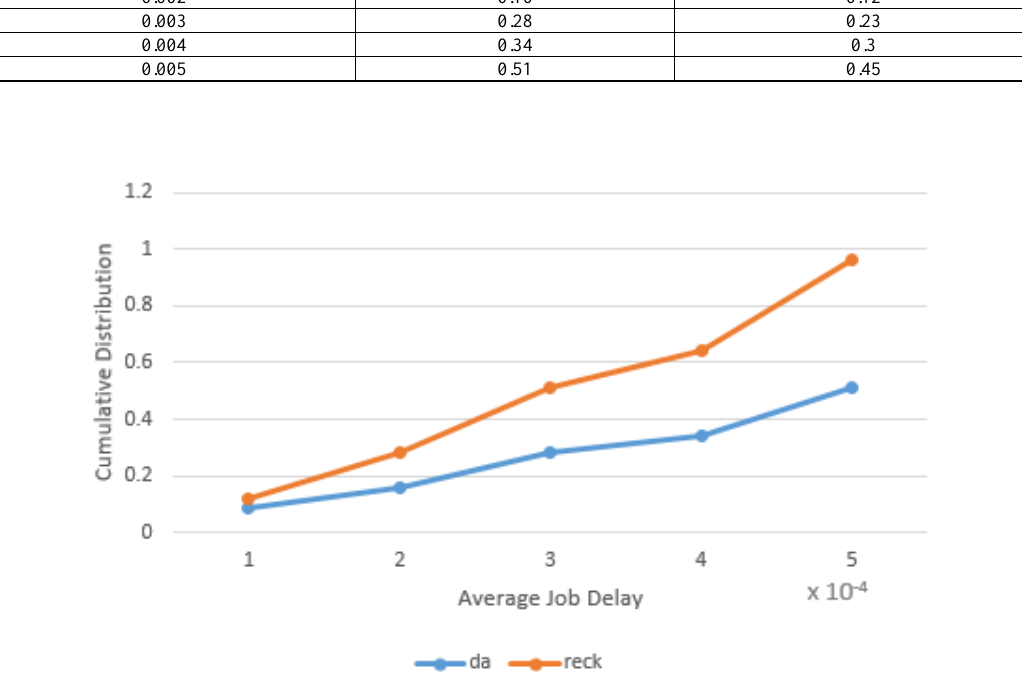
Figure 3. Comparative analysis of DA and RECK algorithm in the context of cumulative distribution and average job delay